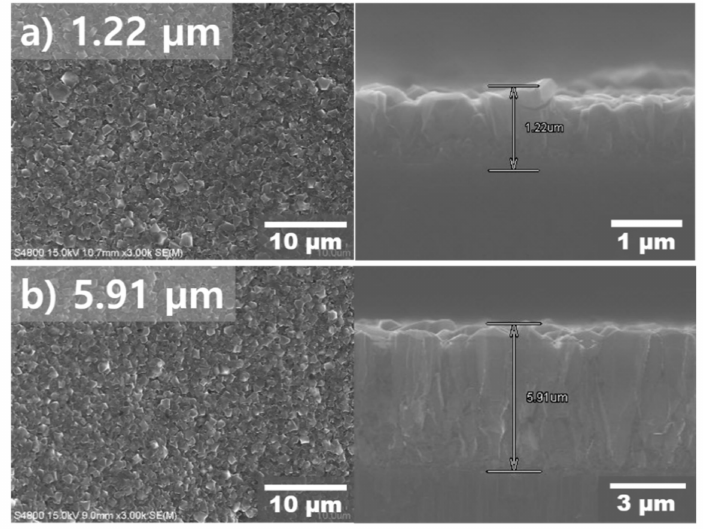
Figure 2. Surface morphology and cross-sectional FE-SEM images of boron-doped diamond (BDD) films deposited for ( a ) 12 h and ( b ) 60